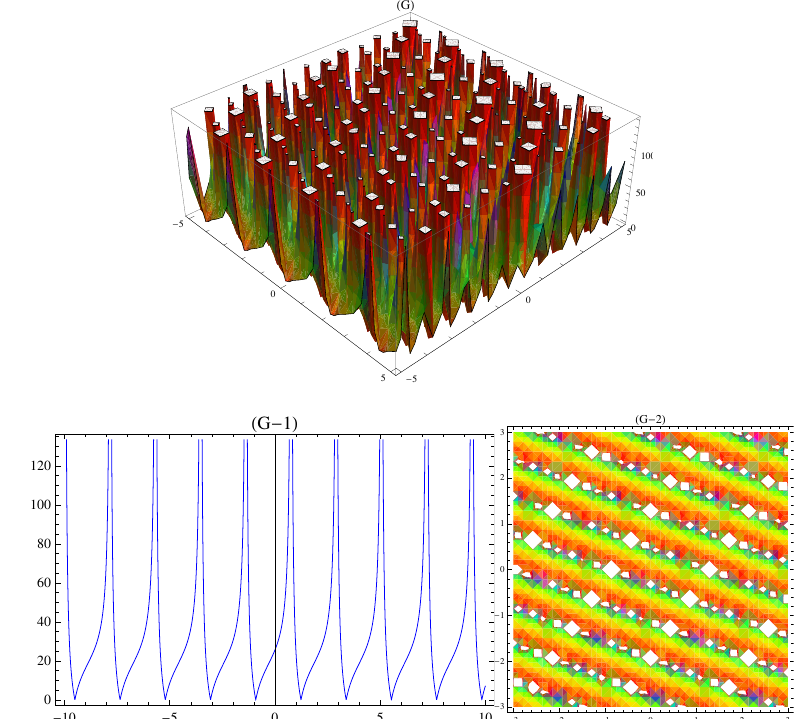
Figure 7: (G) 3D graph of (71) with θ = 1.5 , λ = 2.2 , µ = 2.9 , Θ = 1.7 , p = 0.98 , q = 0.95 , k = 2.2 , A = 2.9 , δ = 2 , ς = 2.1 , c = 3.1 , y = 2.7 , l = 3.8 . (G-1) 2D plot of (71) with t = 1 . (G-2) Contour graph of